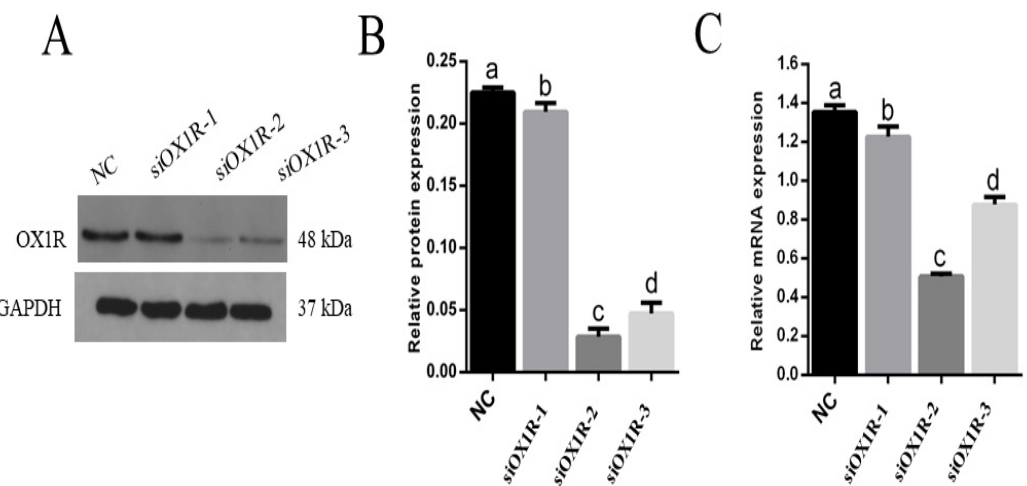
Figure 2. Effect of siRNAs on the expression of OX1R at the protein and mRNA levels in mouse GCs. ( A – C ) The protein and mRNA expression levels of OX1R were measured using Western blotting and RT-qPCR in siRNA-transfected mouse GCs. The values show the expression levels of OX1R relative to β -actin (RT-qPCR) and GAPDH (Western blotting). The data from three independent experiments were presented as the means ± SEM. Different superscripts a,b,c,d represent the level of significance between NC and siRNAs ( p < 0.05). OX1R, orexin receptor 1; GC, granulosa cells; siOX1R, orexin receptor 1 siRNA; NC, negative control; siRNA, short interfering RNA.